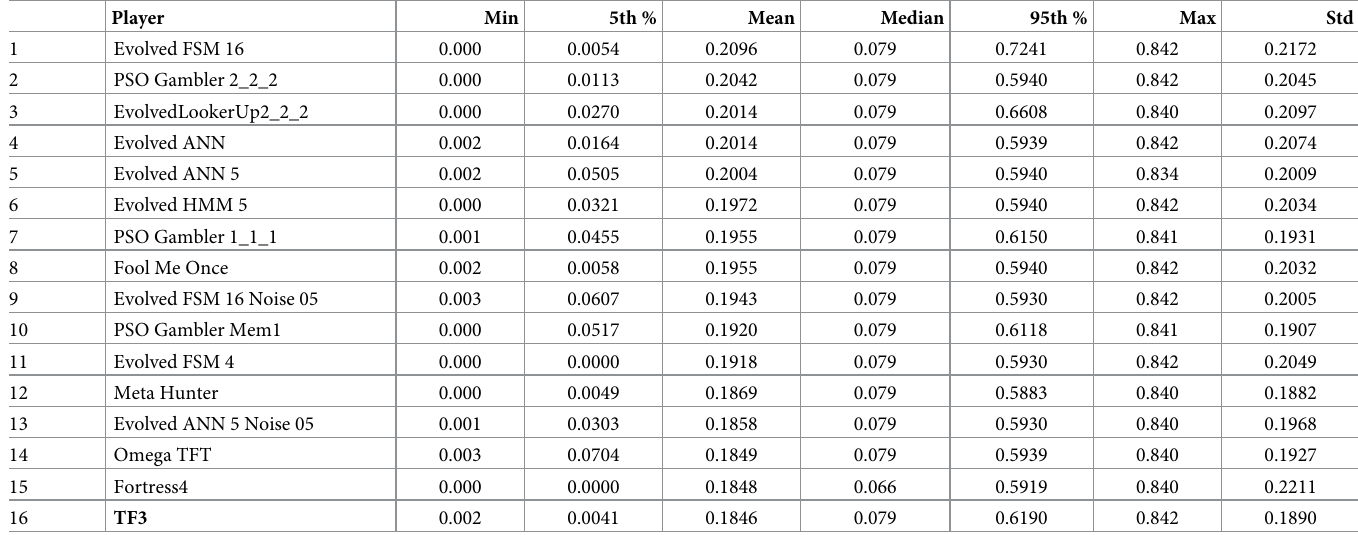
Table 7. Top invaders for N =